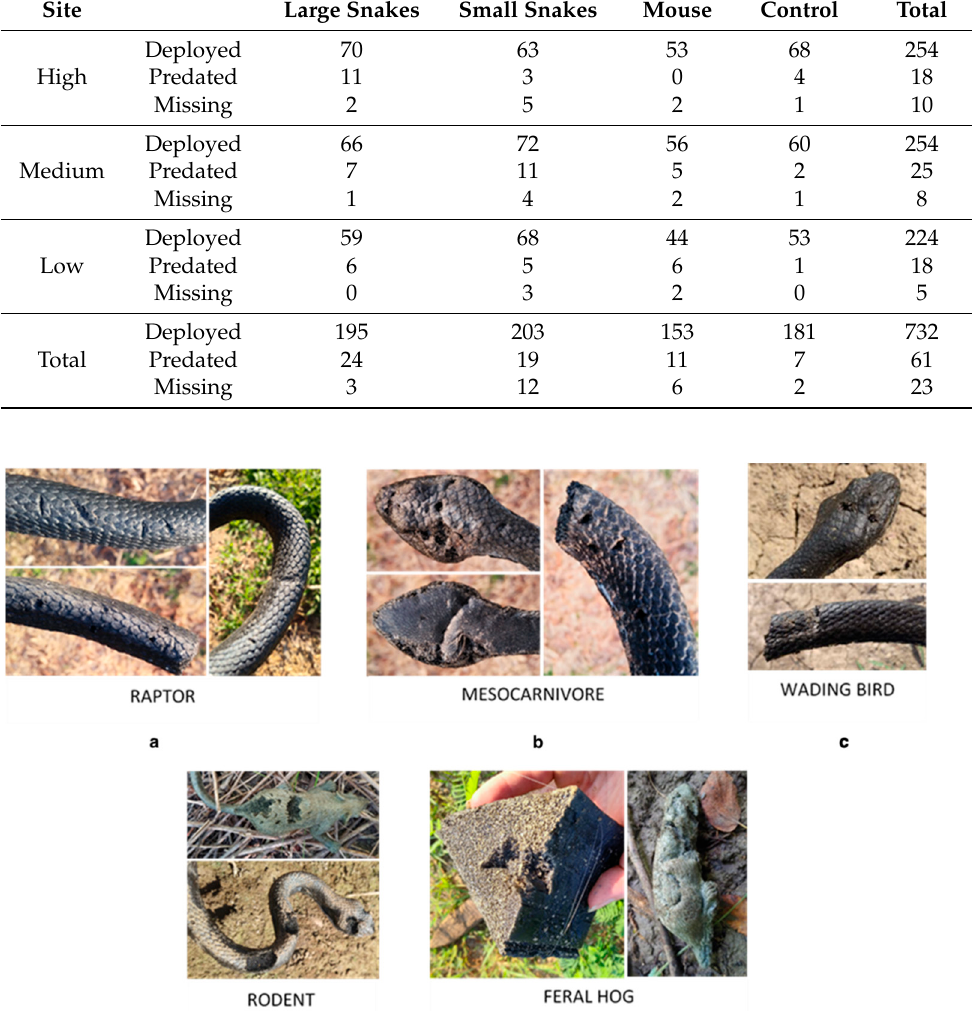
Figure 5. Characteristic depredation marks left by each predator type. These marks were used for identifying predator type for each depredated model. ( a top-left ) Raptor beak (left) and talon marks (right); ( b top-center ) mesocarnivore full bite (left) and tooth marks (right); ( c top-right ) wading bird beak (top) and talon marks (bottom); ( d bottom-left ) rodent gnaw (top and bottom) and tooth marks (top); and ( e bottom-right ) feral hog tooth marks.